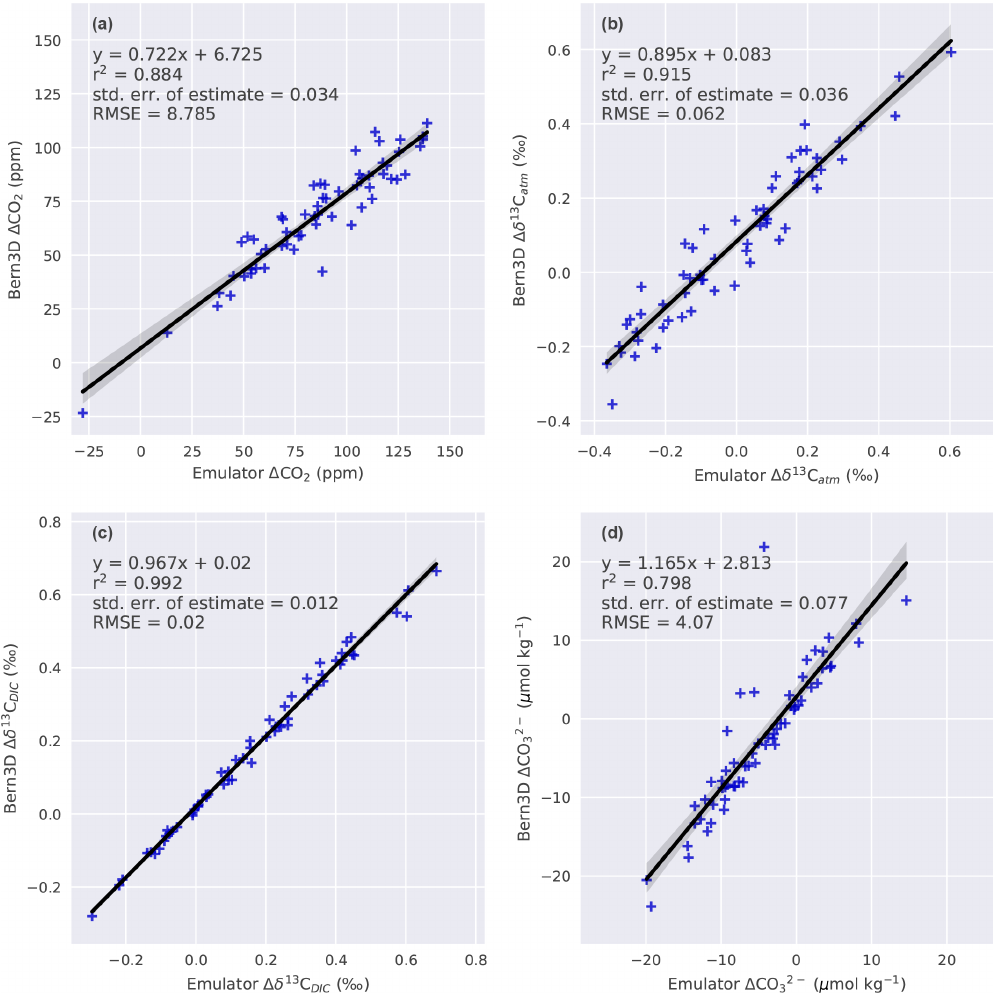
Figure C1. Regression of emulator results for the four data-based constraints against results from a Bern3D LHS ensemble with the same parameter combinations (as outlined in Sect. 2.2). The regres- sion given in the figure is used to correct emulator results for non- linearities (Eq.